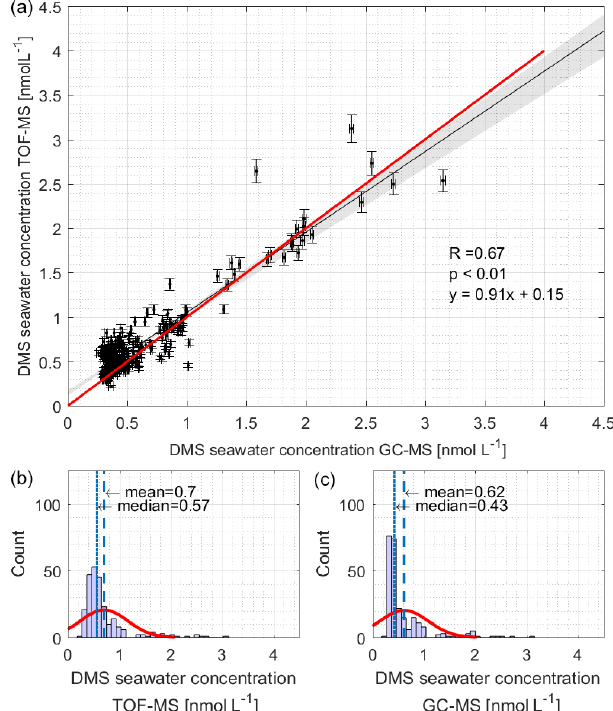
Figure 2. The (a) correlation and (b, c) Gaussian distribution anal- ysis of DMS concentrations measured by TOF-MS (b) and GC–MS ( c ). TOF-MS data were matched to GC–MS data within a ± 5min timing interval. The black line and red line in (a) denote the regres- sion line and the 1 : 1 line, respectively. The red lines in (b) and (c) denote the density